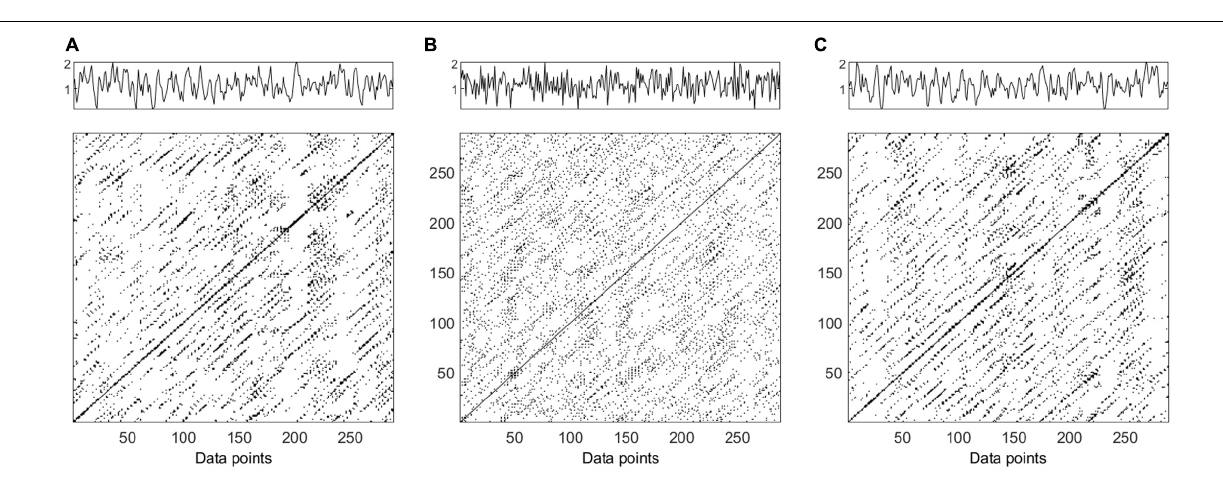
FIGURE 2 | Time series and recurrence plots ( m = 5, τ = 3) for synthetic data AR2s Eq. (1). Original time series (panel A) , one surrogate obtained by Iterative Amplitude Adjusted Fourier Transform (IAAFT) (panel B) and one surrogate obtained by Pinned Wavelet Iterative Amplitude Adjusted Fourier Transform (PWIAAFT) (panel C) . Time series in all panels are shown as arbitrary